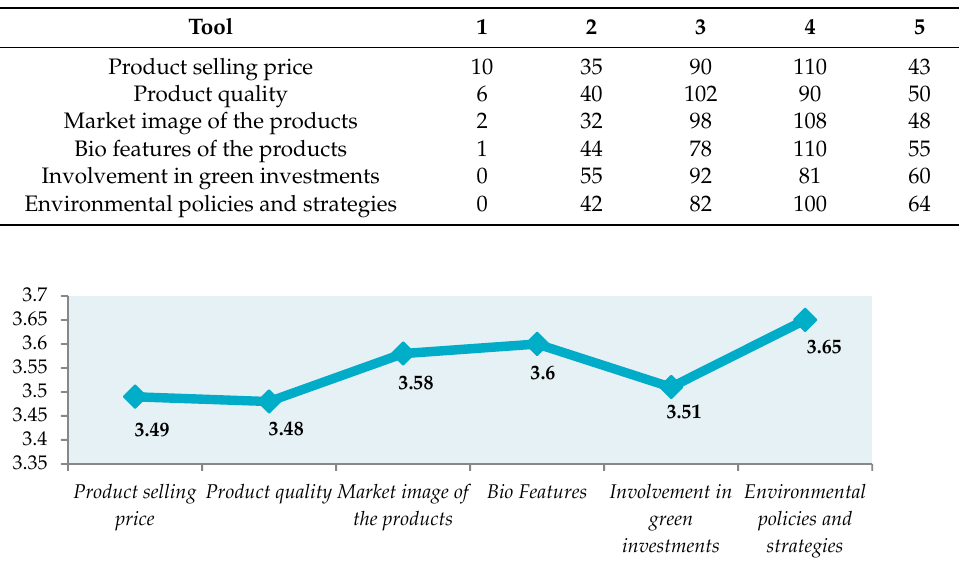
Table 5. Ranking of comparative economic entities against their main competitors.